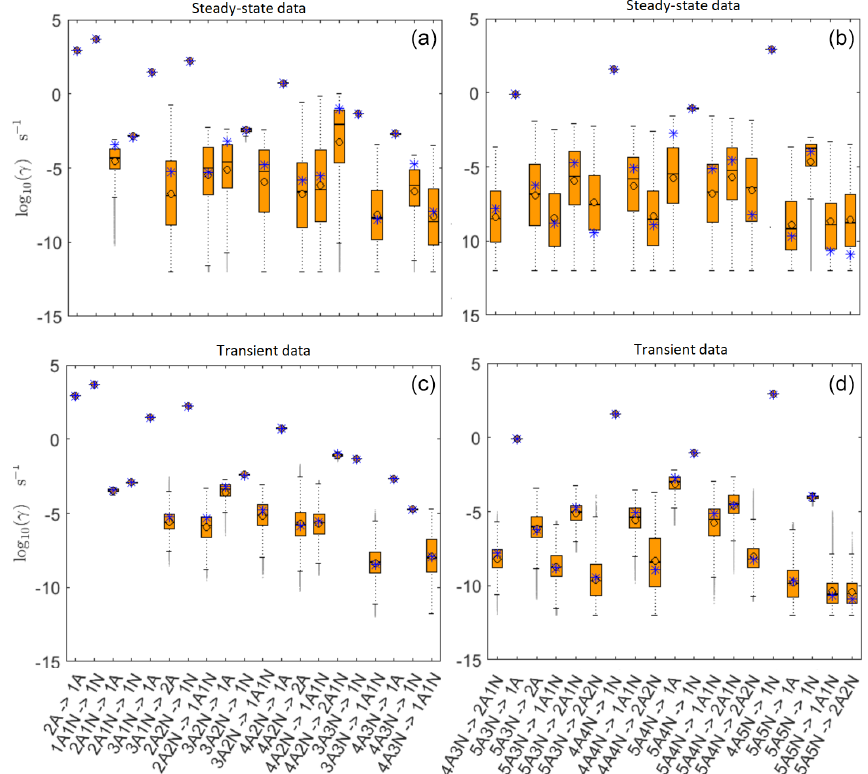
Figure 5. Comparison of 95% confidence intervals (orange box plots) of base 10 logarithms of the evaporation rates determined from (a, b) steady-state and (c, d) time-dependent synthetic data measured at temperature 278K. Here, blue asterisks denote the baseline values used for creating the synthetic data (borrowed from Olenius et al., 2013b). The black circle and horizontal line markers indicate the mode and the mean value of the distribution, respectively. The notation xAyN corresponds to a cluster with x sulfuric acid and y ammonia